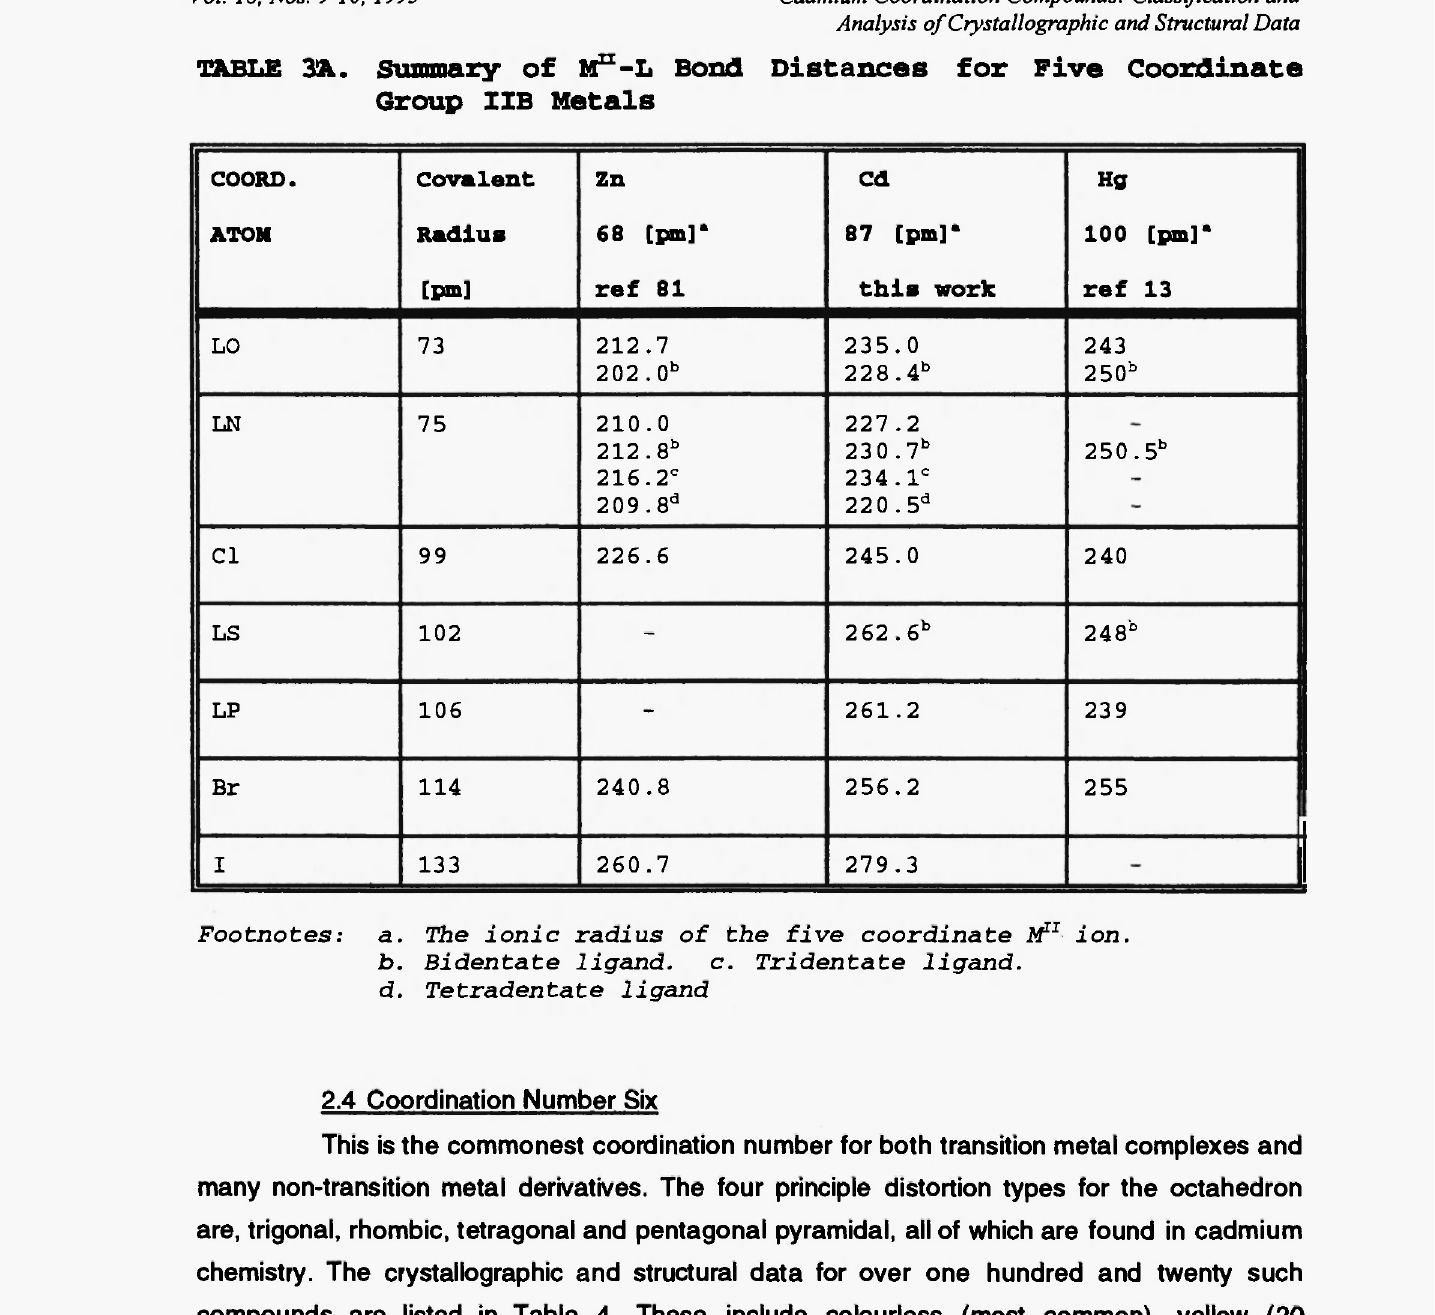
TABLE 3A. Summary of M^-L Bond Distances for Five Coordinate Group IIB Metals